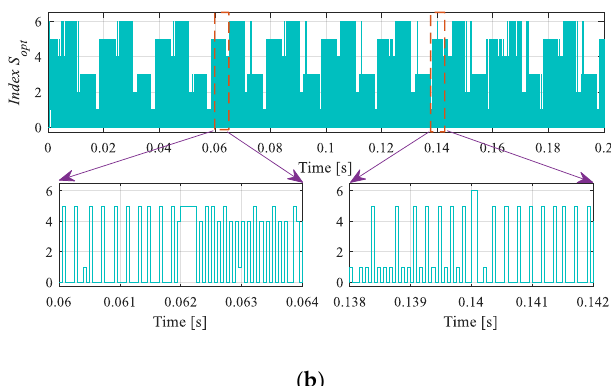
Figure 9. Simulation result: the index number of selected optimum switching state S opt in each sampling interval for the FS-MPC in ( a ) αβ -frame and ( b ) dq -frame.